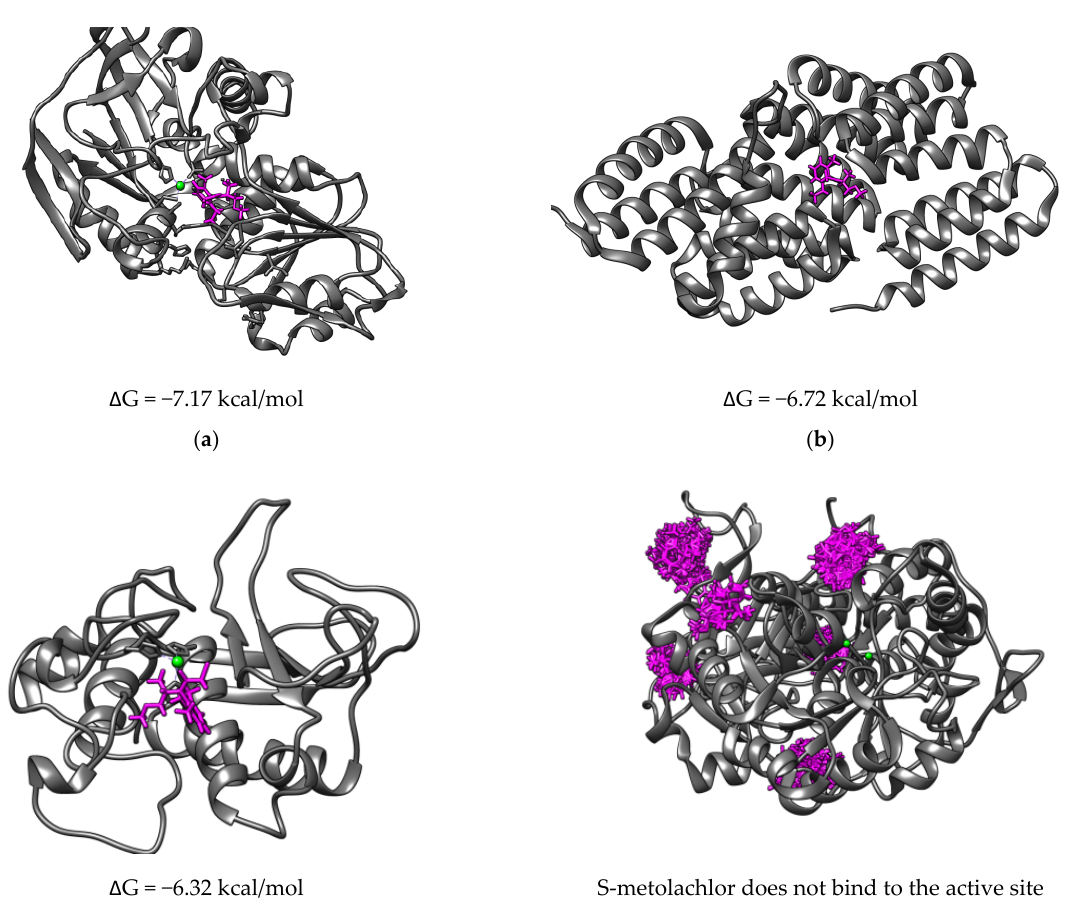
Figure 3. Results illustrating the most favorable binding modes of S-metolachlor to the active sites of dehydrogenase ( a ), phosphatase ( b ) and protease ( c ), respectively all the binding modes for S-metolachlor to urease ( d ). Enzymes are illustrated as dim grey ribbon, S-metolachlor is illustrated as magenta sticks, zinc (in the case of dehydrogenase and protease) and nickel (in the case of urease) ions are illustrated as green spheres. Δ G represents the interaction energy between S-metolachlor and investigated enzymes.